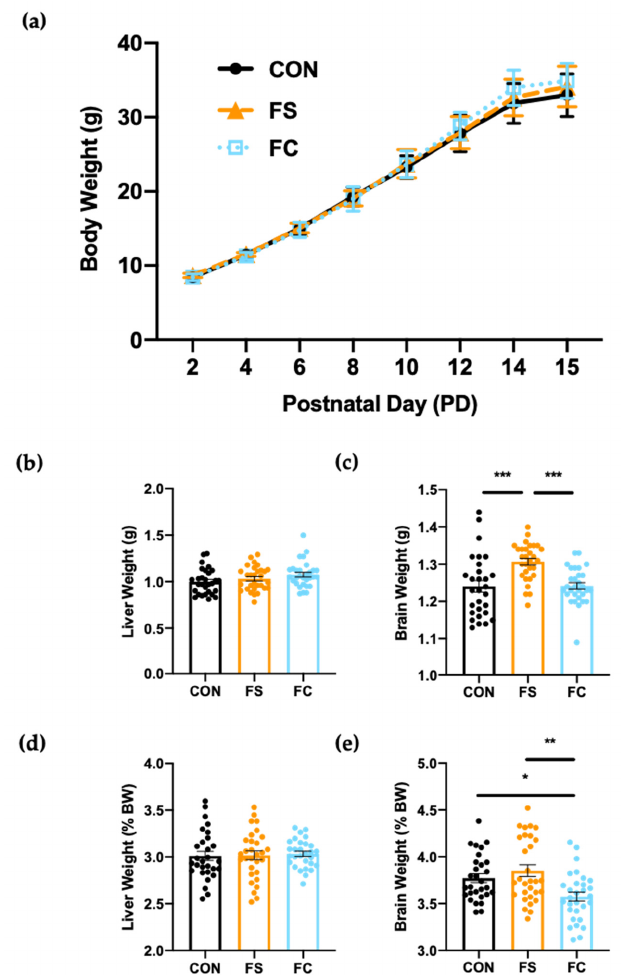
Figure 2. Weight gain and organ development with daily postnatal FS or FC supplementation in rats. ( a ) Pup body weights ( n = 3 litters/group, 10 pups each litter) were recorded across the supplementation period from postnatal day (PD) 2–15; litter averages were analyzed as biological replicates and plotted as mean ± SD. Group and time effects were assessed by repeated-measures two-way ANOVA with Geisser–Greenhouse correction. ( b ) Liver and ( c ) brain weights were recorded at time of collection on PD 15 and normalized to body weight ( d , e ). Organ weight values are plotted as the means ± SEM. p -value summary: *, p < 0.05; **, p < 0.01; ***, p < 0.001. Organ weights were measured on PD 15 at time of collection to detect organ toxicity effects [61]. No effect of sex on liver or brain weight was detected at this age. Treatment influenced brain weight, but results of pairwise comparisons were affected when raw brain weight values were normalized to BW. Mean FS brain weight (raw weight in g) was greater than in the FC and CON groups ( p < 0.05; Figure 2c). However, mean FS brain weight (% BW) was not different from CON, and FC brain weight (% BW) was significantly lower than both FS ( p < 0.01) and CON ( p < 0.05; Figure 2e). With or without normalization, FS brains were significantly heavier than FC brains. Liver weight, in contrast, was not different between groups ( p = 0.10; Figure 2b), and this remained true when values were normalized to body weight ( p = 0.99; Figure 2d). Overall, brain development was affected by iron supplement form and this effect does not appear to be related to iron status, since iron status was similar between the FS and FC groups (Figure